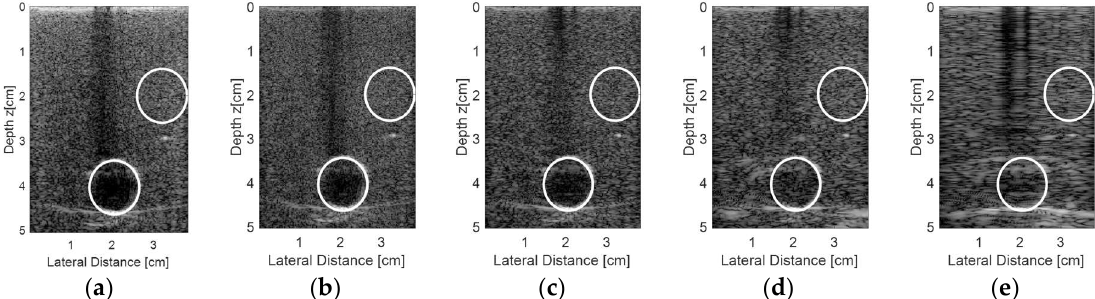
Figure 16. Regions of interest to quantify the contrast for the images obtained with ( a ) the Verasonics platform (DAS method), ( b ) processed with the Stolt migration method for all 128 elements and using the sparse array condition with ( c ) 65 active elements, ( d ) 44 active elements, and ( e ) 23 active elements.